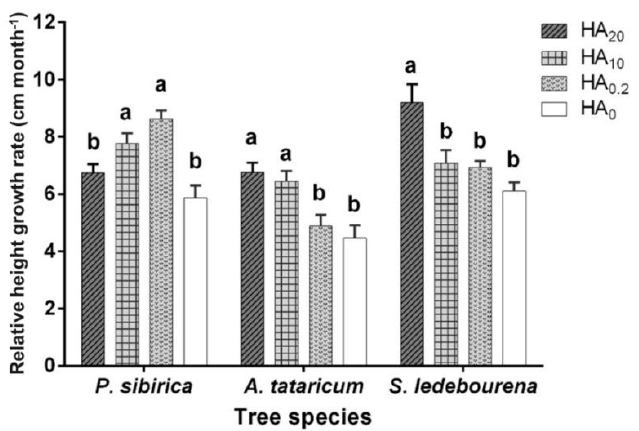
Figure 1. The comparative analysis of different treatment and years with RHGR. Humic acid was applied at HA 20 (20,000 mg L − 1 ), HA 10 (10,000 mg L − 1 ), HA 0.2 (2000 mg L − 1 ), and HA 0 (0 mg L − 1 ) oxidized brown coal humic fertilizers m 2 yr − 1 , respectively. Mean followed by the same letters are not significantly different at the 0.05 level (Duncan’s multiple range test).